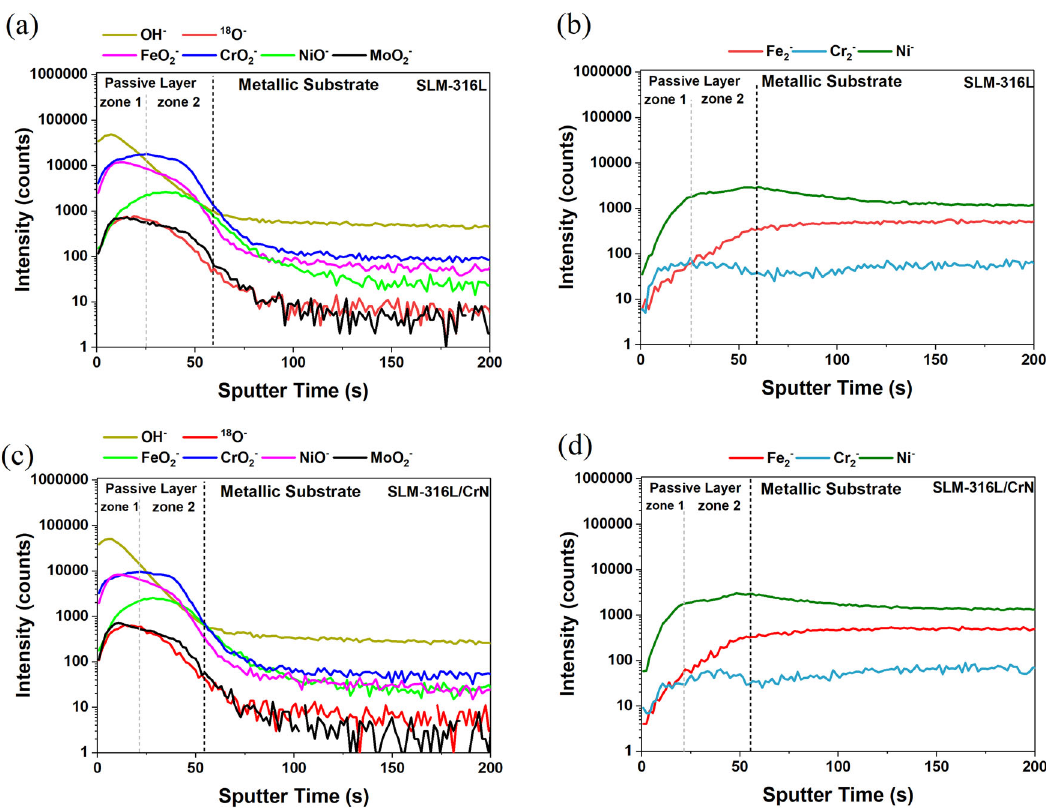
Fig. 8 Passive fi lm characterization using ToF-SIMS. ToF-SIMS negative ion depth pro fi les of ( a , b ) SLM-316L and ( c , d ) SLM-316L/CrN after immersion in 3.5 wt% NaCl for 24 h at room temperature.